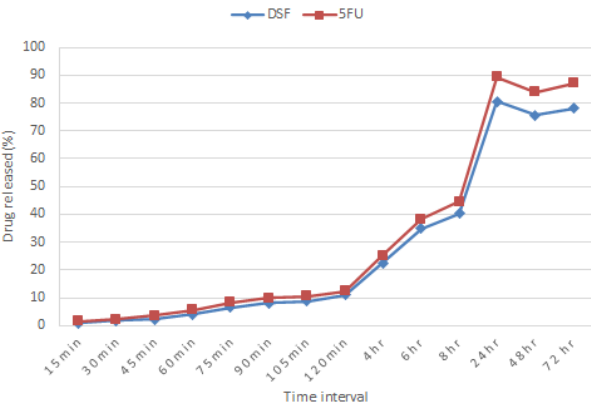
Figure 7. The bilayer release profiles of DSF and 5-FU at 37 ± 1 °C in 2% SDS solution (pH 4.2).